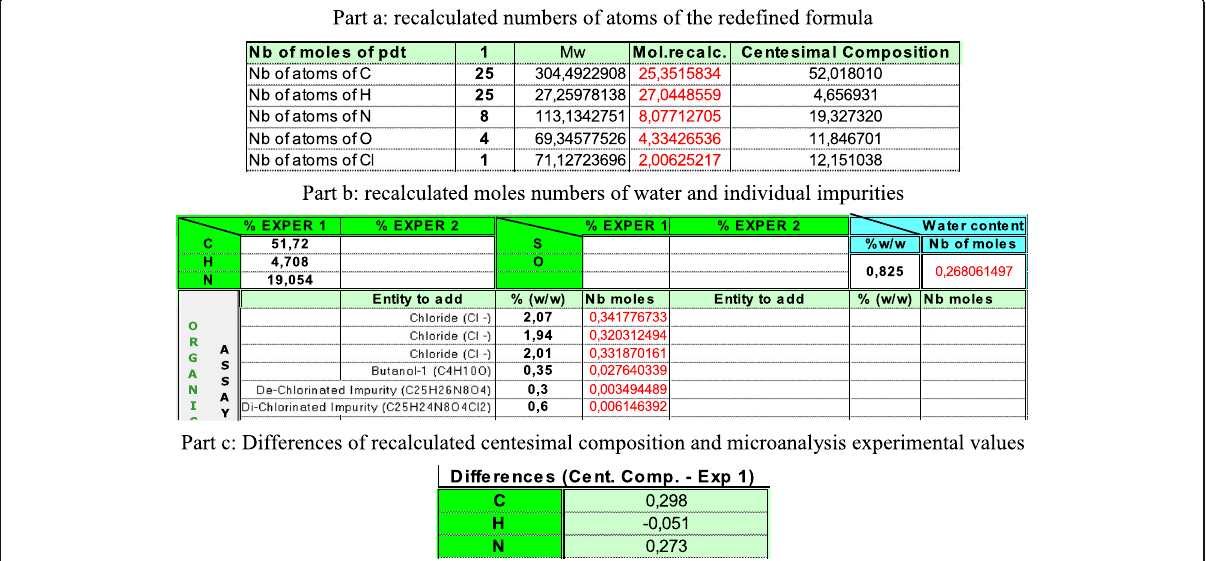
Fig. 7 User interface screenshots (parts a, b, c) –– second exploitation of experimental results, including those related to the impurity profile, by Mat-CHN for the compound C 25 H 25 N 8 O 4 Cl,